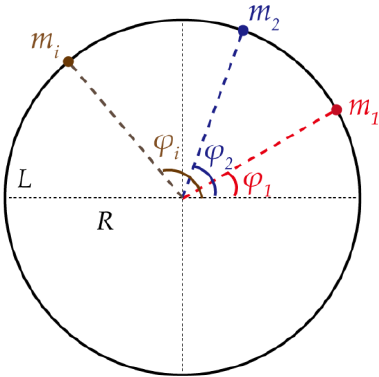
Figure 1. The ring with unbalanced mass.